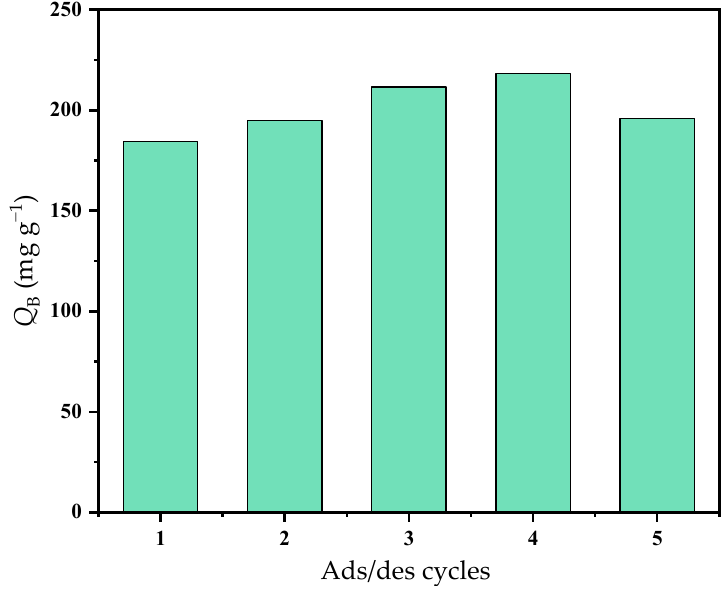
Figure 5. Reusability of SSA/MCM–41 in the cyclic experiments.